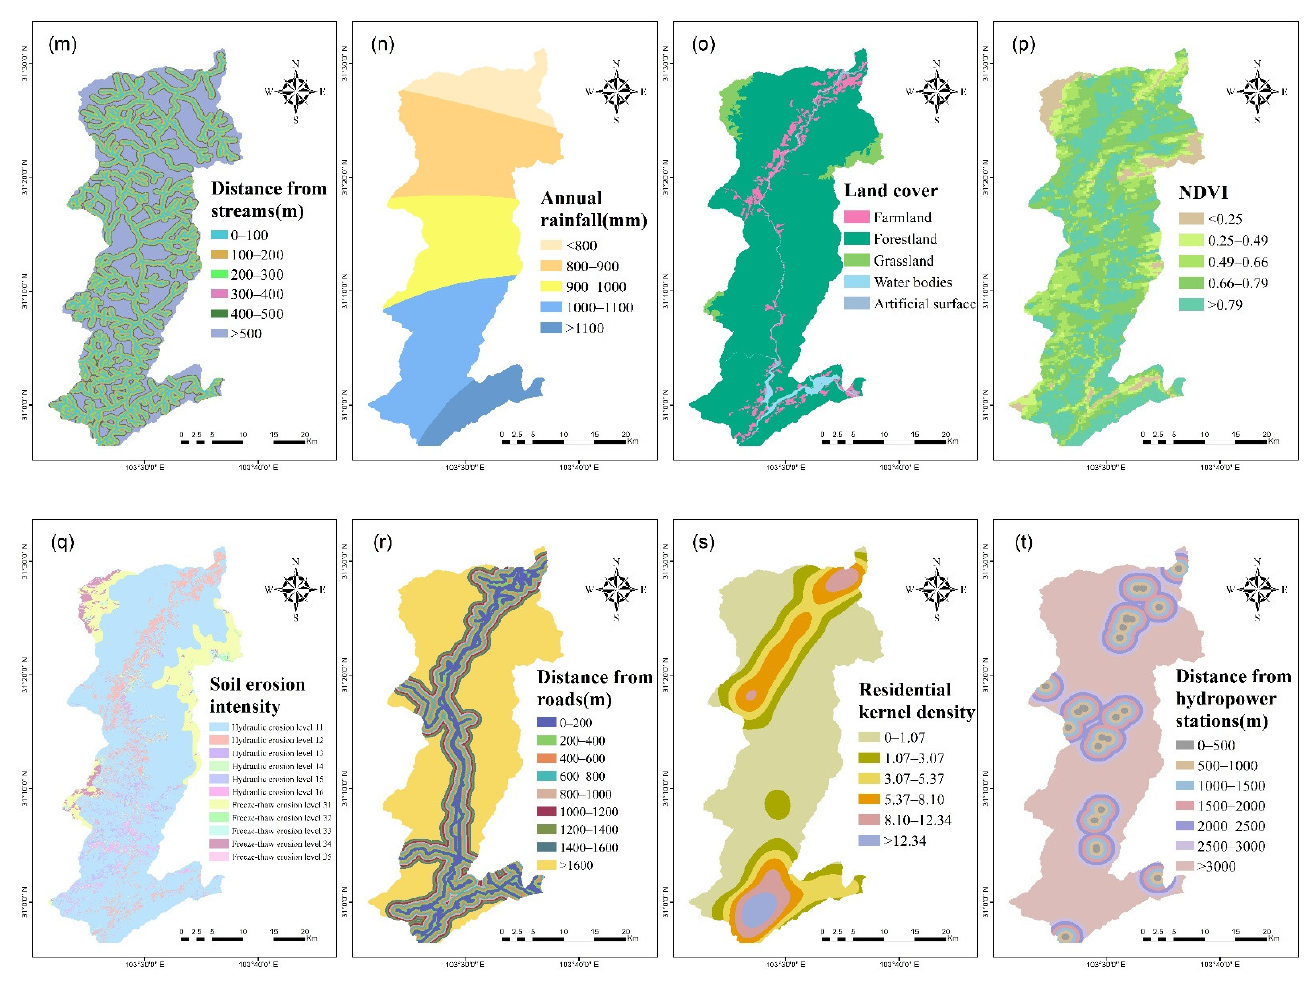
Figure 2. Landslide influencing factor layers: ( a ) altitude; ( b ) slope; ( c ) aspect; ( d ) plan curvature; ( e ) profile curvature; ( f ) degree of relief; ( g ) topographic wetness index (TWI); ( h ) lithology; ( i ) seismic intensity; ( j ) distance from fault zones; ( k ) stratigraphy; ( l ) distance from main rivers; ( m ) distance from streams; ( n ) annual rainfall; ( o ) normalized difference vegetation index (NDVI); ( p ) land cover; ( q ) soil erosion intensity; ( r ) distance from roads; ( s ) residential kernel density; ( t ) distance from hydropower stations.